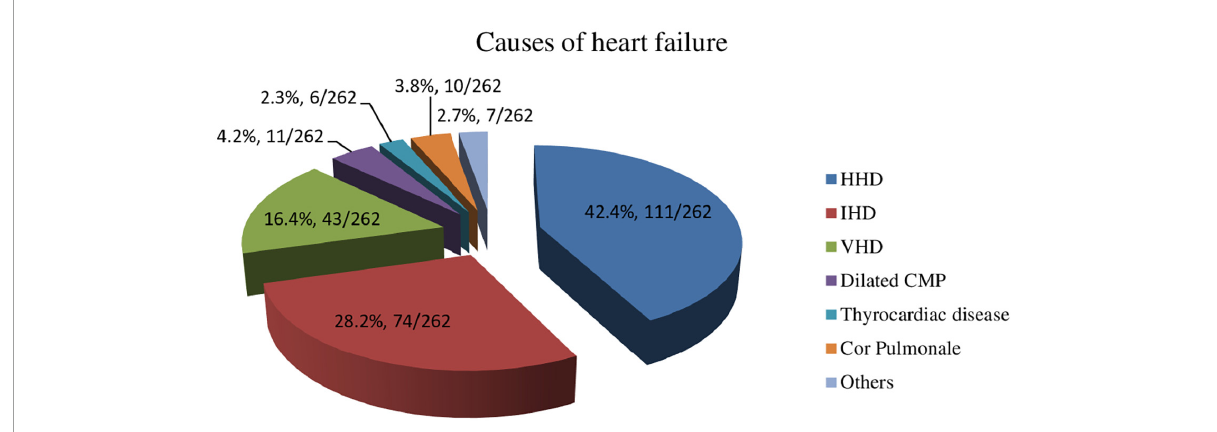
FIGURE1 Causes of heart failure among patients aged 50 years or older with heart failure.